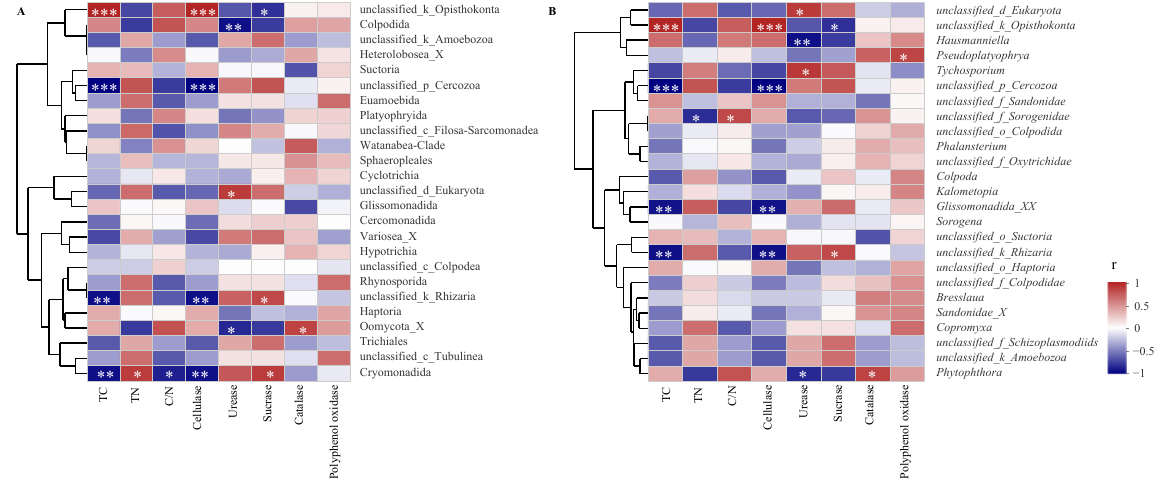
Figure 6. Spearman’s rank correlation analysis between the dominant protists and litter properties at an order ( A ) and a genus ( B ) level (* p < 005; ** p < 0.01; *** p <